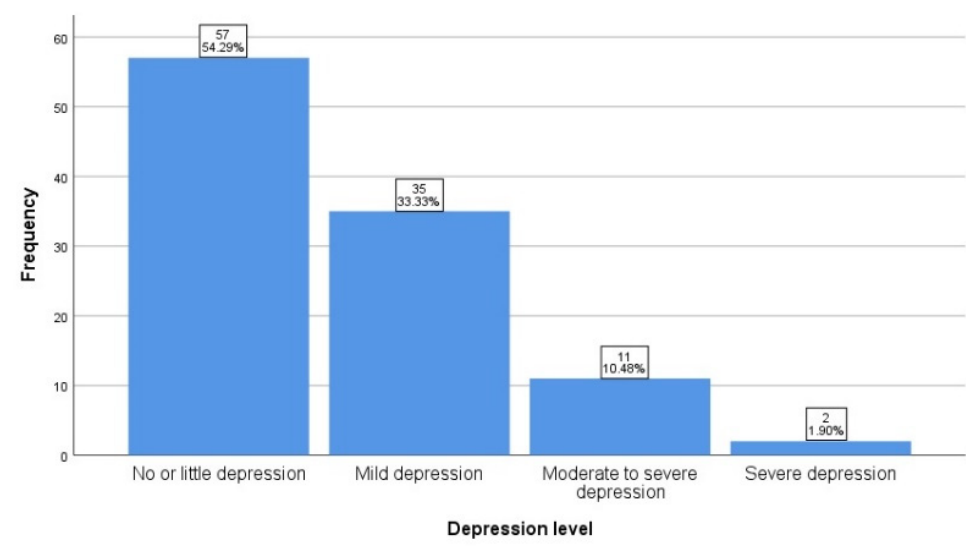
Figure 1. Frequency of second-time mother’s depression.